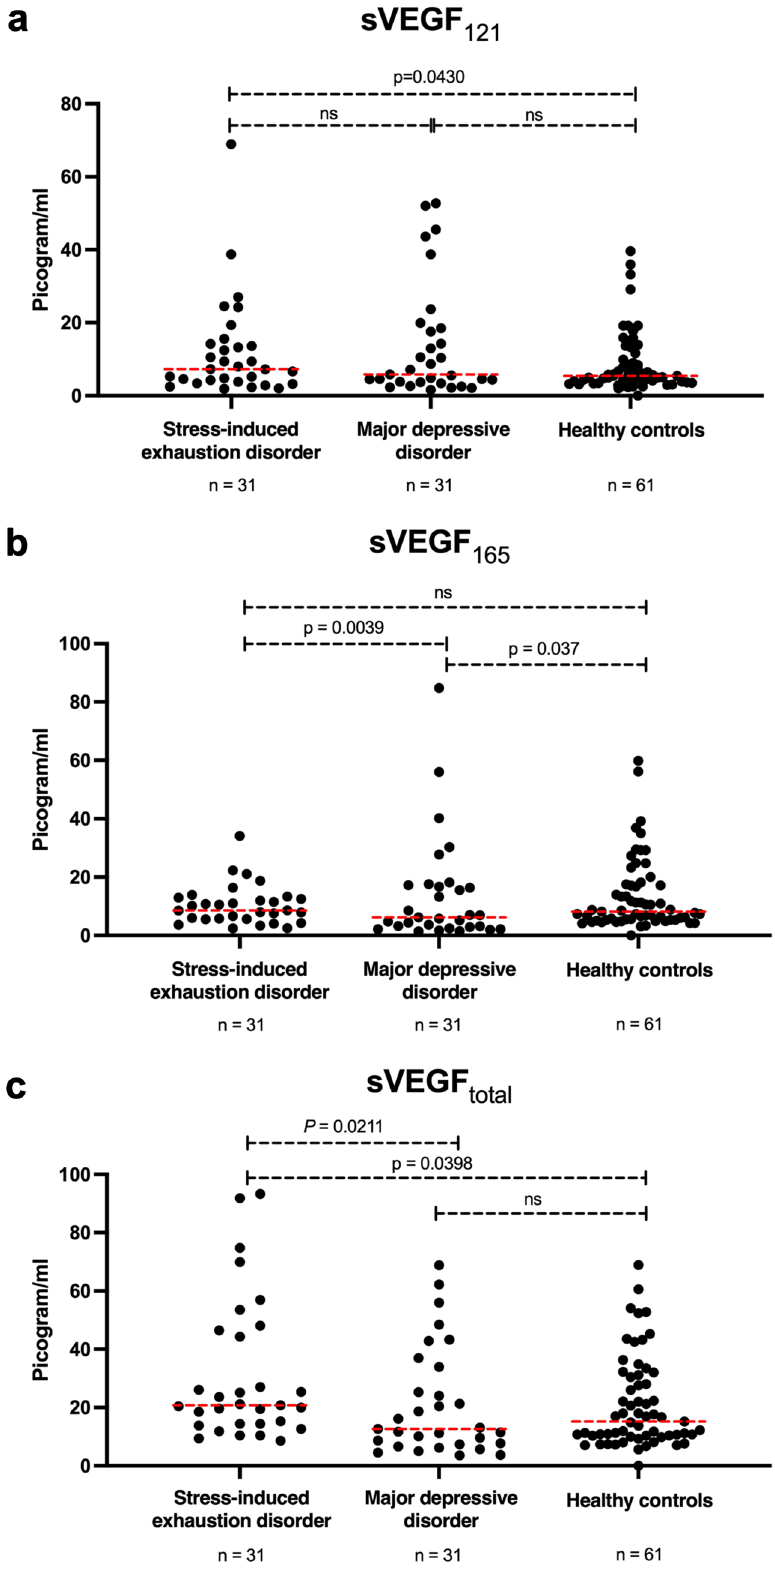
Figure 1. Plasma levels of vascular endothelial growth factor (VEGF) 121 and VEGF 165 as measured by enzyme- linked immunosorbent assay (ELISA). Data are presented as VEGF 121 , VEGF 165 , and VEGF total (VEGF 121 plus VEGF 165 ); ns not